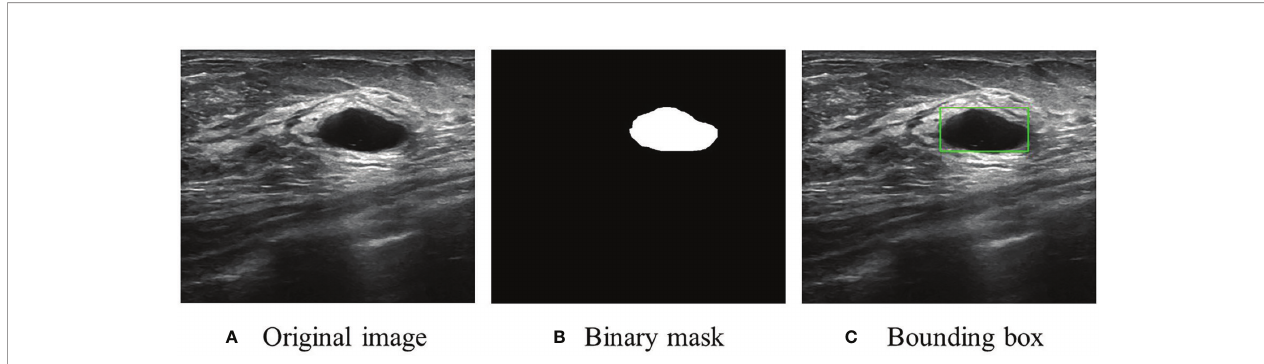
FIGURE 1 | An US image sample. (A) Original image. (B) Original segmentation ground truth in binary mask form provided by (22). (C) Conversion to bounding box as the ground truth for RoI detection and